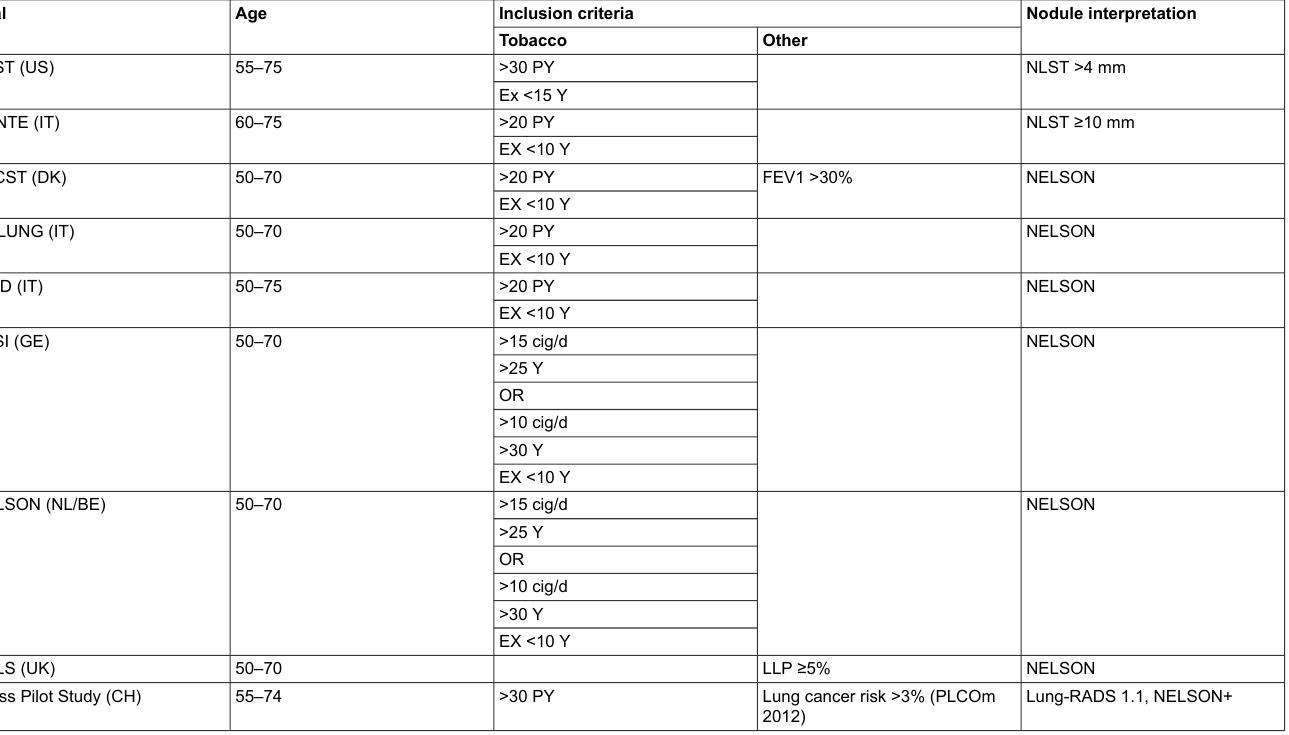
Table 2: Inclusion criteria and nodule management of different screening programs [4, 19, 55–60]. Trial Age Inclusion criteria Nodule